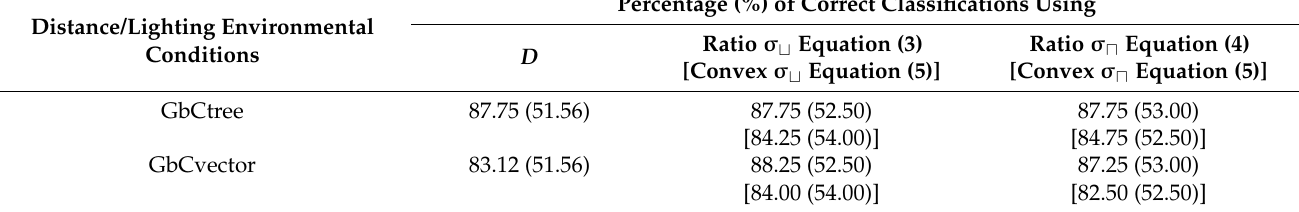
Table 10. Results by GbC classifiers both optimized and non-optimized (within parentheses) for sigmoid positive valuation function regarding face